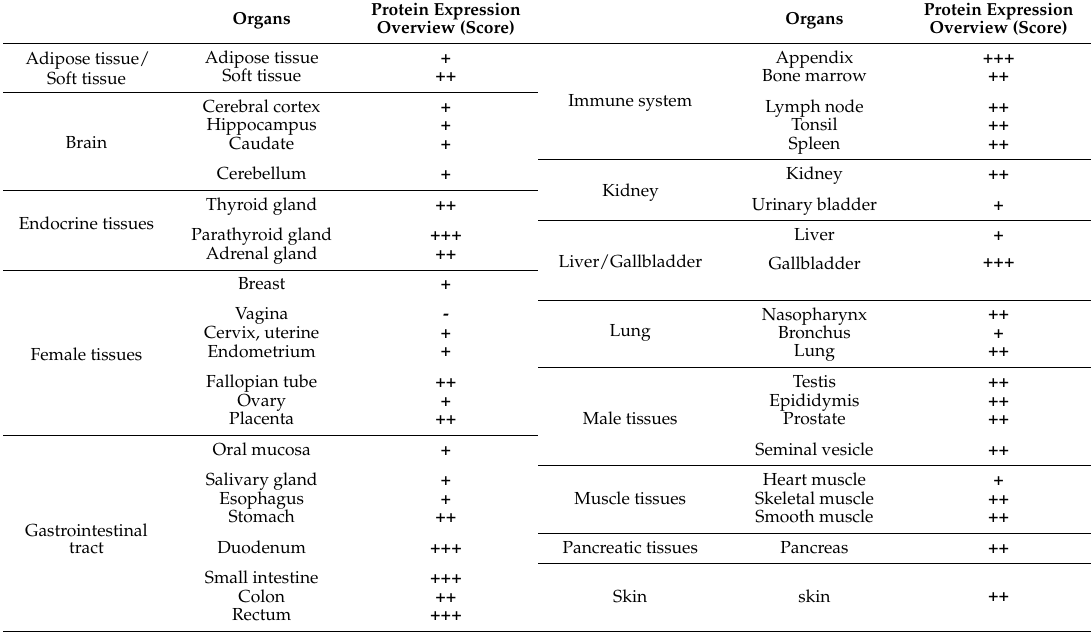
Table 2. Tissue expression of human USP15 provided by Human Protein Atlas database (available on: http://www.proteinatlas.org). The signal intensity of USP15 protein levels was scored as follows: - , negative; + , low; ++ , moderate; +++ , high. Organs Protein Expression Overview (Score) Organs Protein Expression Overview (Score) Adipose tissue/ Soft